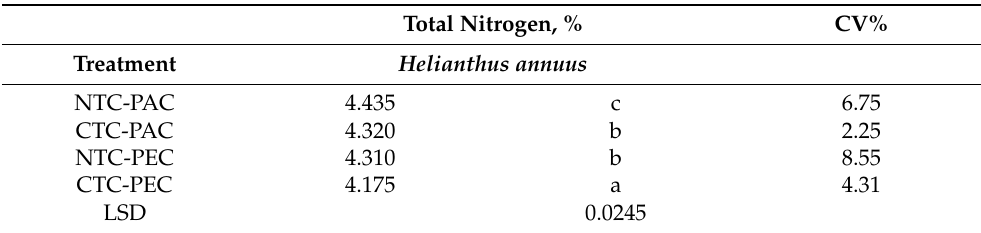
Table 2. Total nitrogen (%) of the Helianthus annuus cultivation in the 4 different soil practice treatments in the second growing